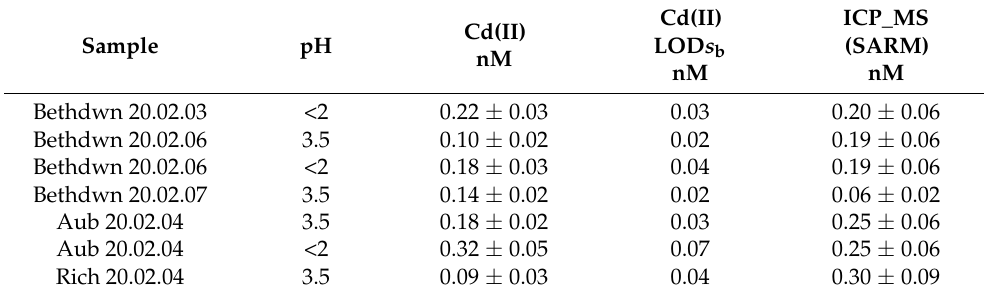
Table 8. Cd(II) results obtained for the standard additions (deposition time 180 s) in the filtered river samples at pH 3.5 and strongly acidified (<2) and its comparison with the ICP-MS results obtained in the strongly acidified